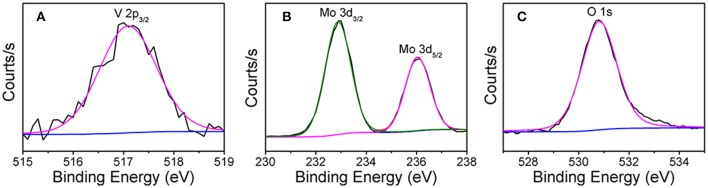
XPS spectra of (A) V 2p, (B) Mo 3d, and (C) O 1s electrons in V0.13Mo0.87O2.935 nanowires.